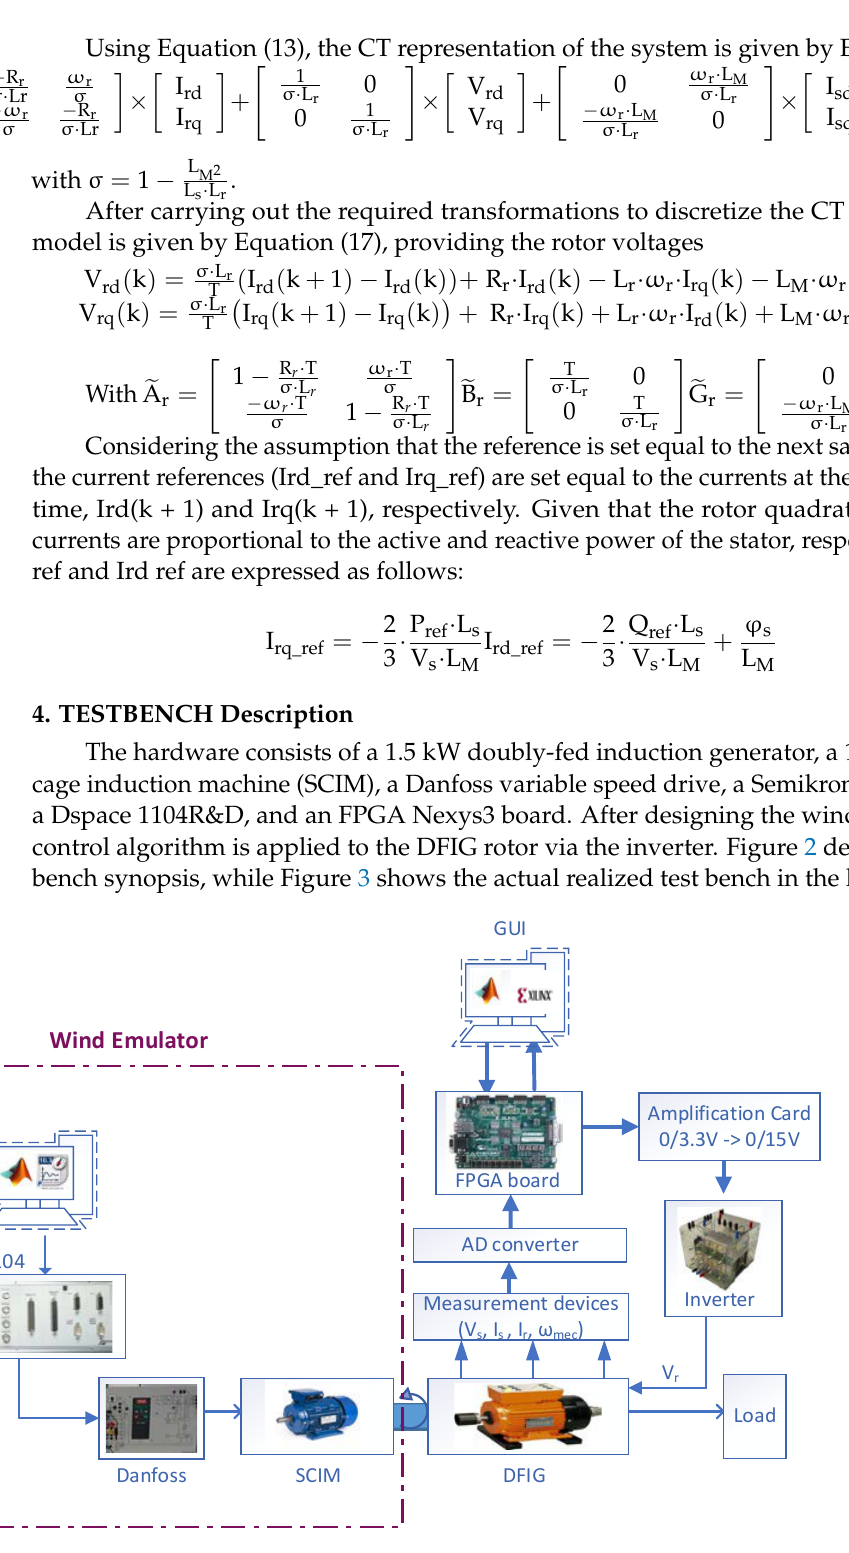
Figure 2. Test bench synopsis.